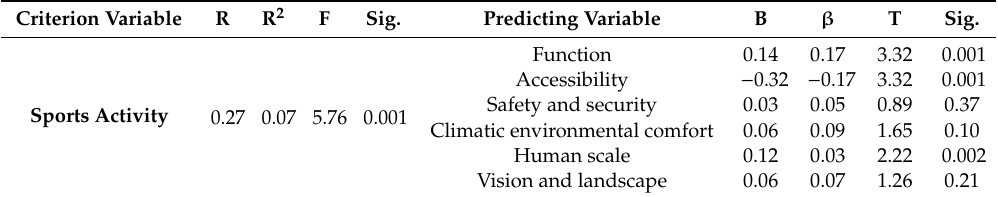
Table 7. Results of regression analysis test for predicting sports activity.